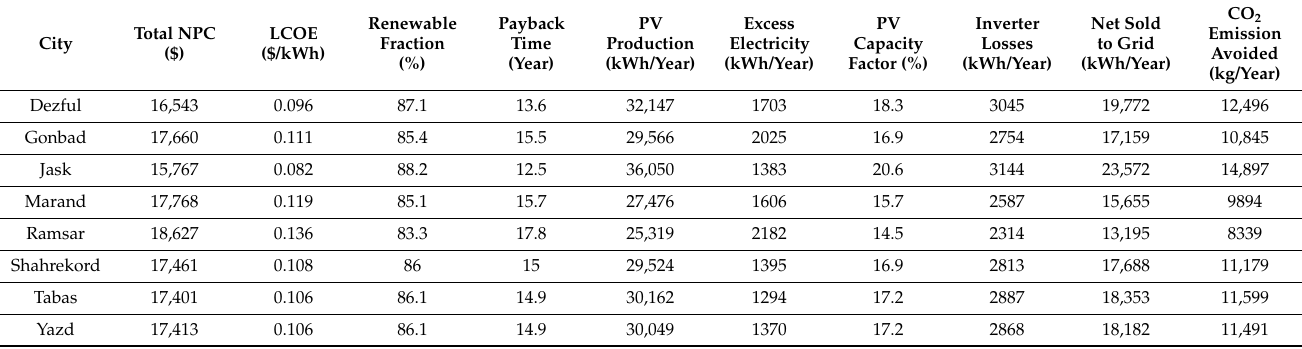
Table 4. Results of slope 0 ◦ .